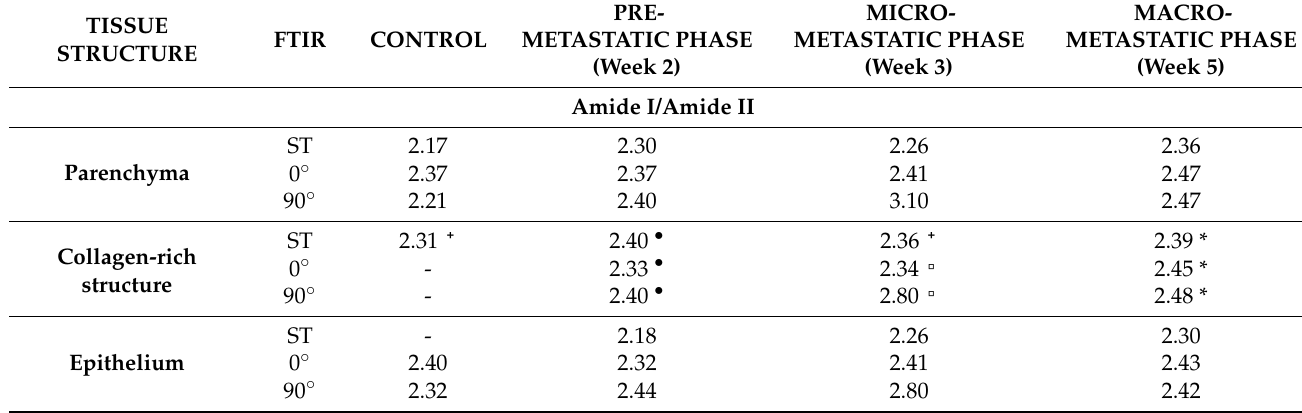
⁺ collagens fibers in longitudinal cross-section of vessel and bronchiole wall; ● fibrotic tissue; ▫ high collagenous contribu- tion in vessel and bronchiole wall; * tumor with fibrosis.